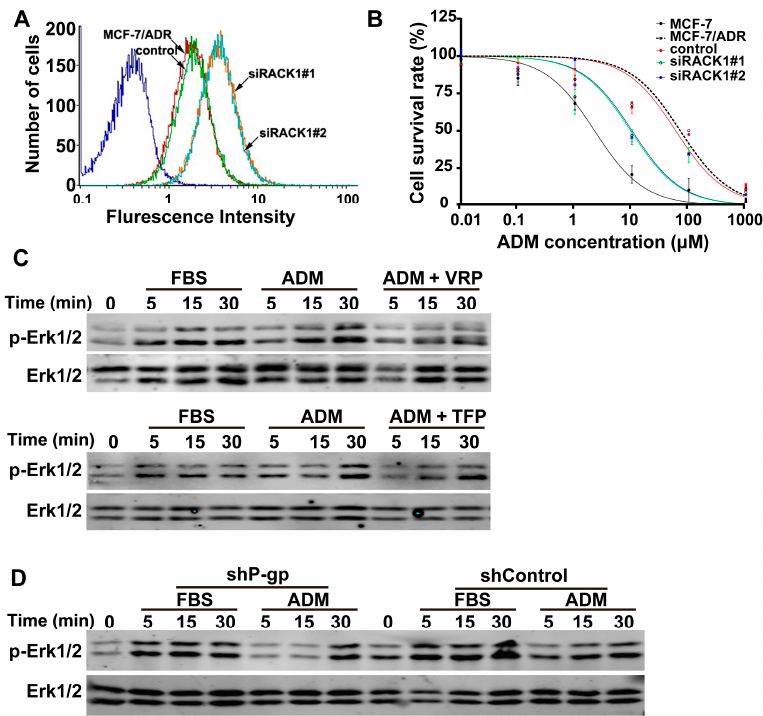
Figure 6. Knockdown of Rack1 inhibited P-glycoprotein activity and P-gp is required for adriamycin (ADM)-induced Erk1/2 phosphorylation. ( A ) Knockdown of Rack1 significantly reduced the efflux rate of fluorescent dye Rh-123 in MCF-7/ADR cells as measured by using flow cytometry; ( B ) Knockdown of Rack1 enhanced the drug sensitivity to adriamycin in MCF-7/ADR cells. Control and Rack1 silenced cells were seeded in a 96-well plate at a density of 1 × 10 4 cells per well and cultured for 24 h. Then, different concentrations of adriamycin were added into each well. After incubation for 72 h at 37 ◦ C, the cell viability was determined using the CCK-8-based method by measuring the absorbance at 450 nm on a micro-ELISA reader. The assays were performed using three replicates for each drug concentration. IC 50 was calculated by using the GraphPad Prism 6.00 software; ( C ) Inhibition of P-gp activity inhibited adriamycin-induced Erk1/2 phosphorylation. Cells were starved for 24 h in the presence or absence of TFP or VRP and then exposed with different concentrations of adriamycin for different time points, then cells were lysed, and total cell lysate was further analyzed by Western blotting. FBS was used as positive control; ( D ) Knockdown of P-gp impaired adriamycin-induced phosphorylation of Erk1/2 in MCF-7/ADR cells. Control and P-gp knockdown cells were starved for 24 h and then exposed with different concentration of adriamycin for different time points; the cells were lysed and total cell lysate was further analyzed by Western blotting. FBS was used as a positive control. VRP, verapamil; TFP, trifluoperazine.